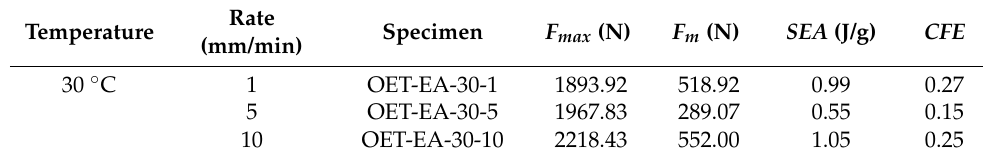
Table 4. The specific data of each evaluation index of OET.